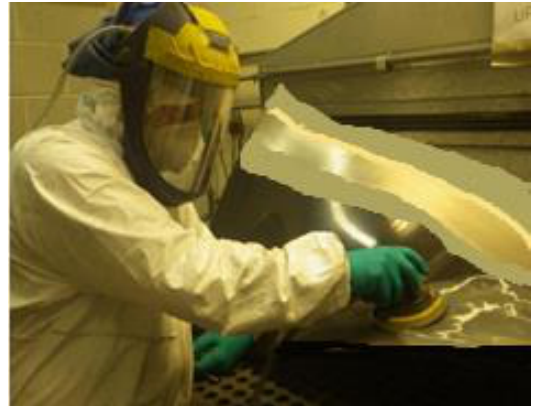
Figure 1. A worker performing manual grinding operation (We have smudge areas of the fan blade due to Intellectual Property reasons.). due to Intellectual Property